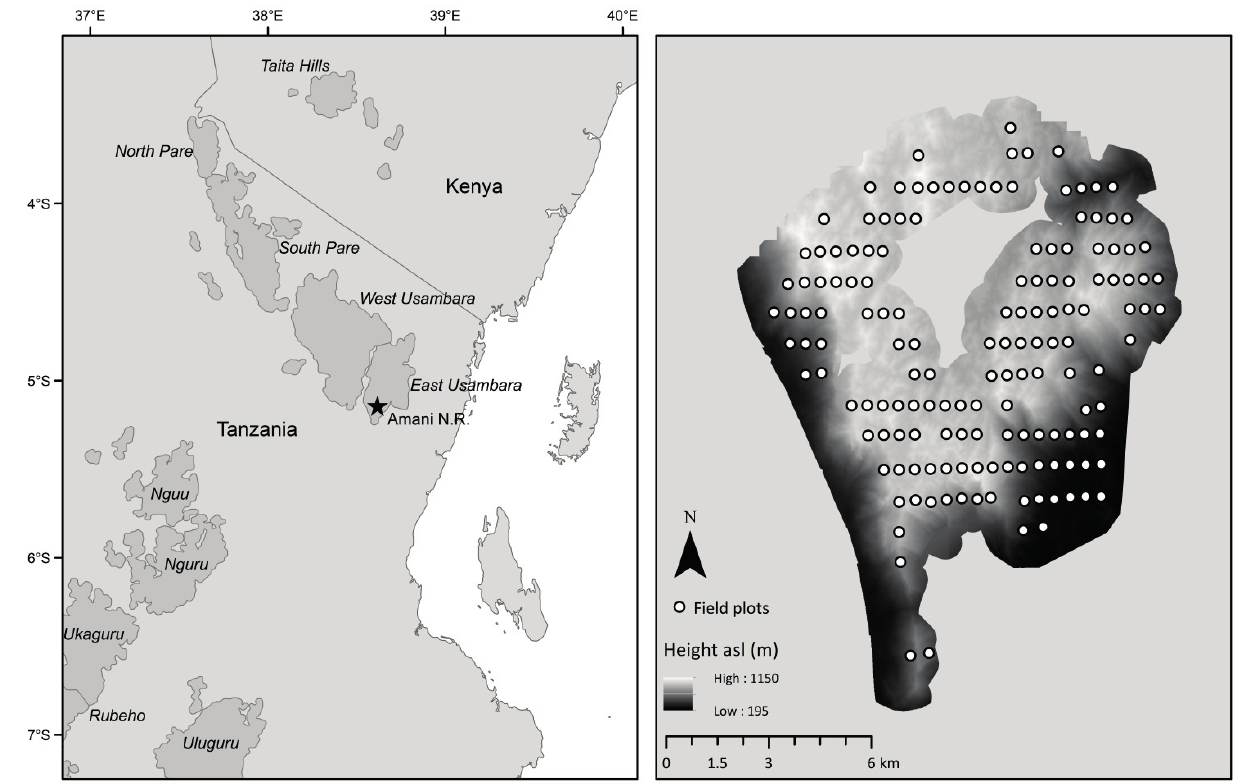
Figure 1. Left: study area (marked by star) situated in the Eastern Arc Mountains (dark grey areas). Right: field plot locations (marked by dots) inside the Amani Nature